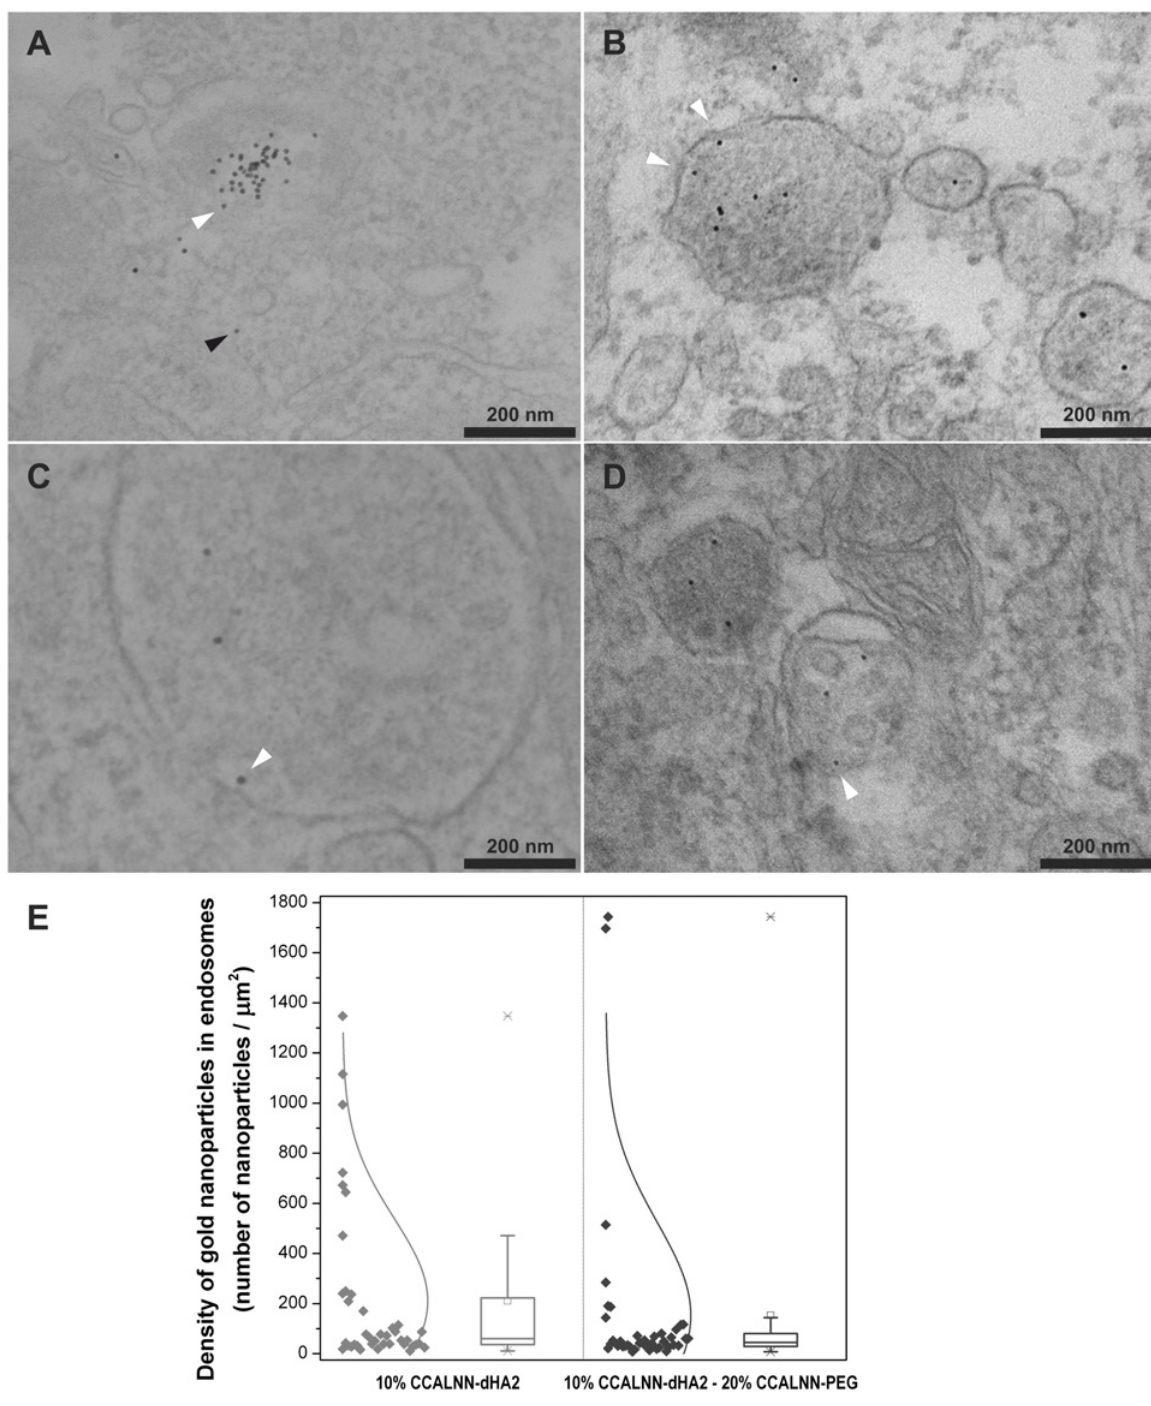
Fig 2. Effect of PEG on the intracellular localisation of HA2 fusion peptide functionalised gold nanoparticles. HeLa cells were incubated with peptide- coated 10nm gold nanoparticles (6nM) for 4h, washed thoroughly with PBS, fixed and imaged by electron microscopy. Nanoparticle peptide monolayer composition: (A-B) 10% CCALNN-dHA2 and 90% CALNN, (C-D) 10% CCALNN-dHA2, 20% CCALNN-PEG and 70% CALNN. Arrowheads point toward gold nanoparticles either interacting with vesicular membranes (white), or displaying a cytosolic localisation (black). (E) Density of nanoparticles in endosomes estimated from images shown in (A-B), n = 30; and (C-D), n = 29. The sets of images analysed as well as additional images are available on figshare (10. 6084/m9.figshare.875584, 10.6084/m9.figshare.875630).